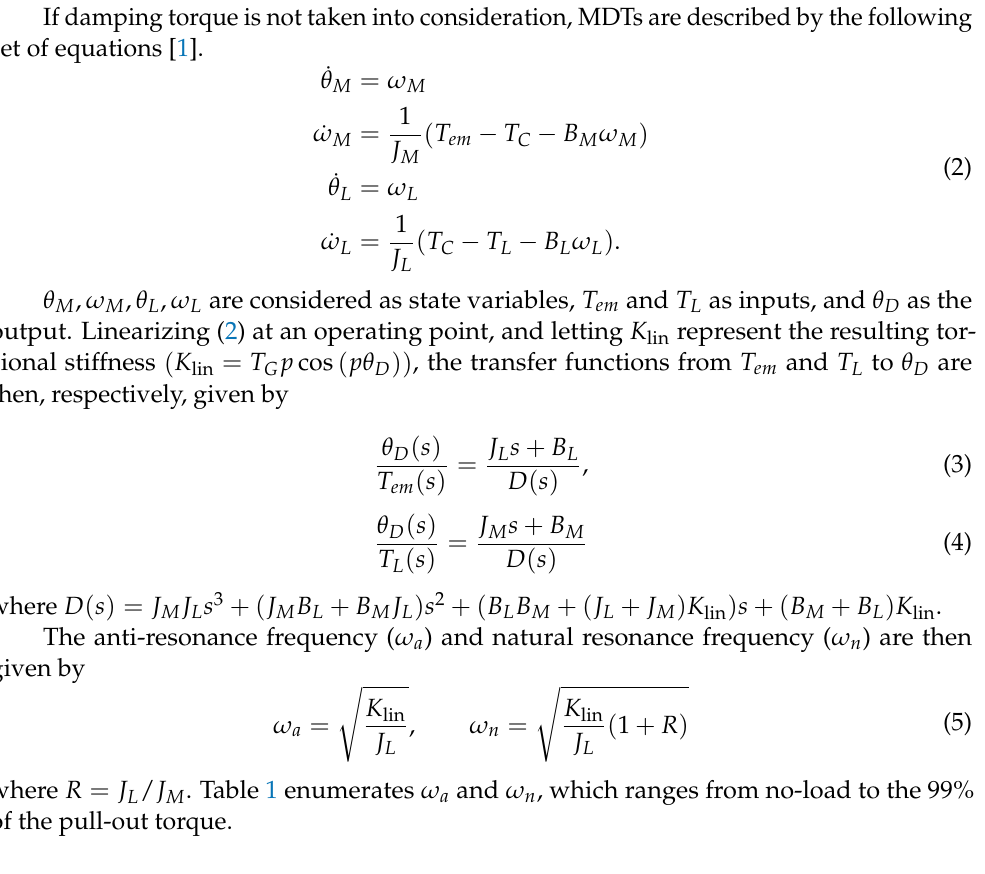
Table 1. ω a and ω n of the MDT rig subject to various percentages of pull-out torque